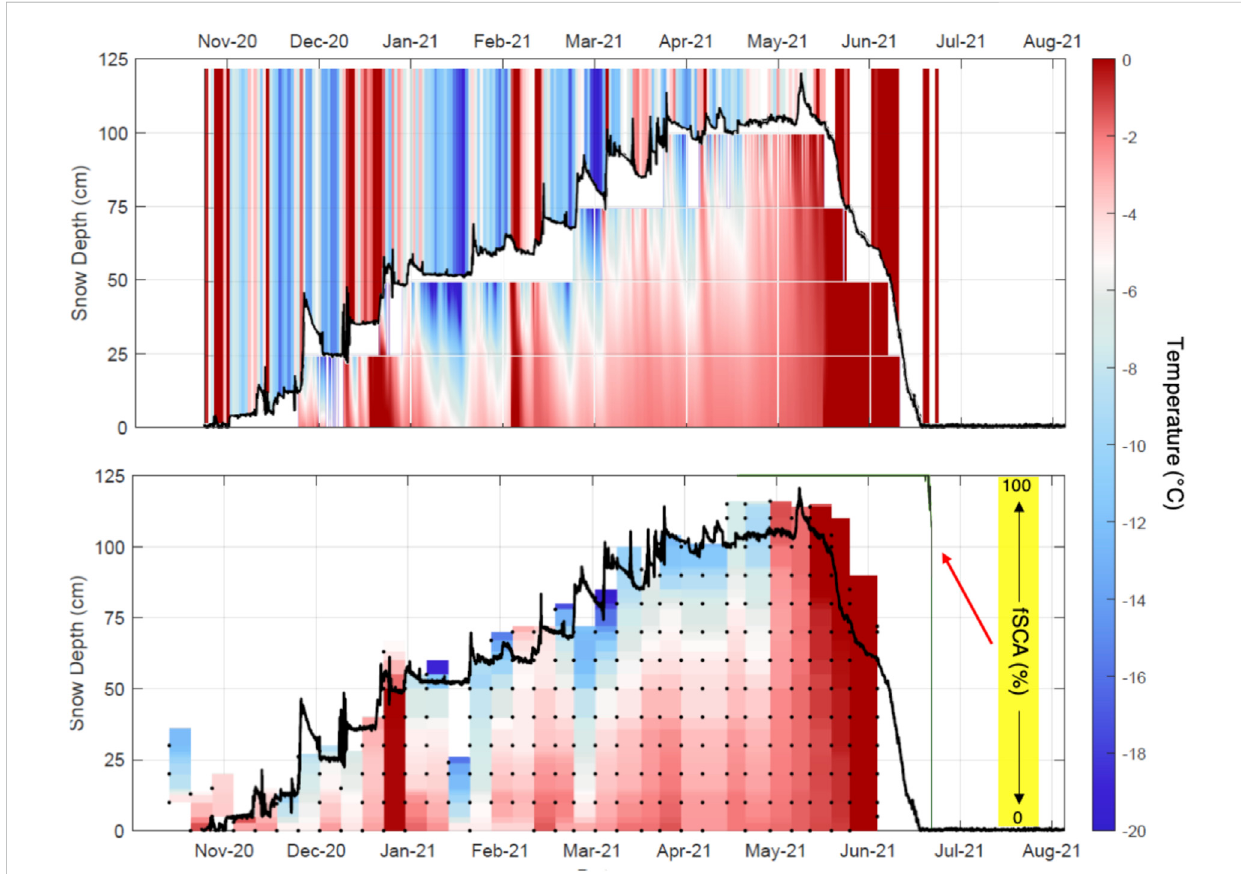
FIGURE 2 Snow depth and temperature pro fi le in Gruvebadet (Ny-Ålesund) over the snow season 2020 – 2021. In both panels, the tick black line indicates the snow depth acquired by the ultrasonic sensor. The upper panel shows the thermal gradient of the snowpack inferred from the ANS temperature sensors (installed at 5, 25, 50, 75, 100, 125 cm) with vertical-colored stripes in the background indicating the 2-m air temperature at the Climate Change Tower (CCT) about ~700 m far from Gruvebadet. Lower panel shows manual measurements of snow height and snow temperature carried every week for comparison. Finally, the dark green line indicates the fractional snow-cover area (fSCA) retrieved by the NIR camera during the melting